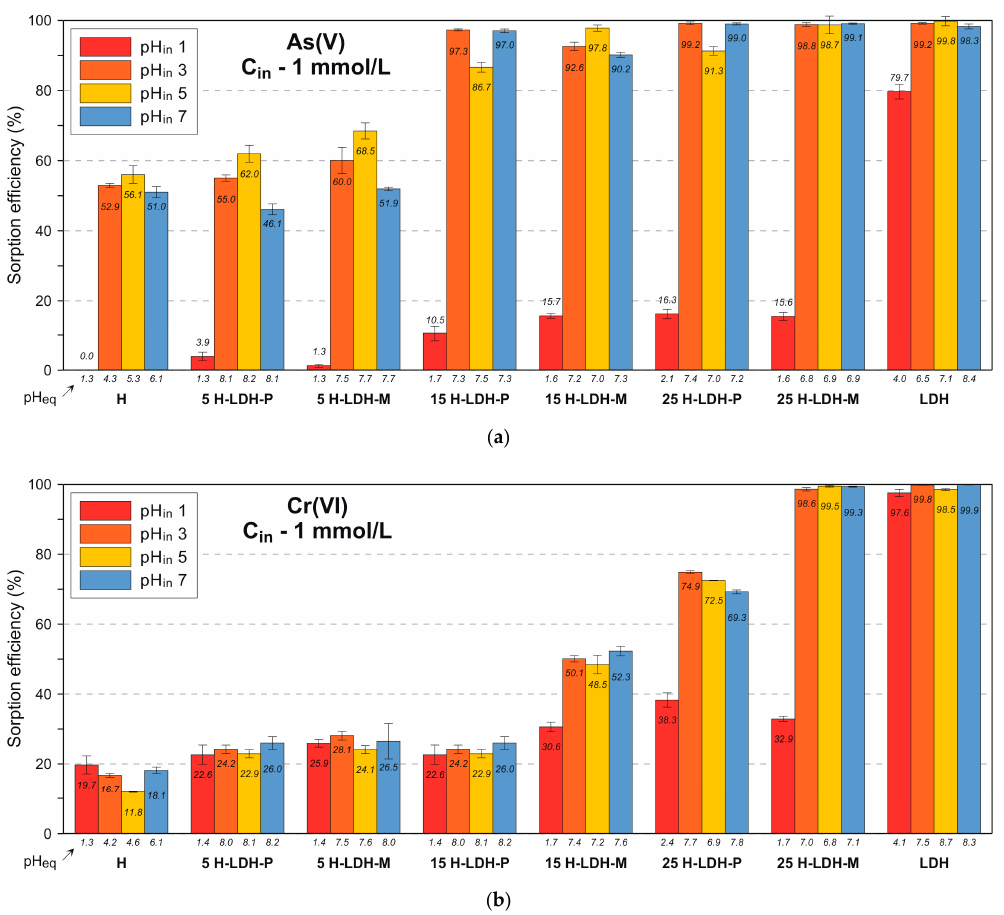
Figure 5. Adsorption efficiency after reaction of the adsorbents with ( a ) As(V) and ( b ) Cr(VI). Initial concentration (C in ) 1 mmol/L. Error bars may not be visible due to low discrepancy of results.